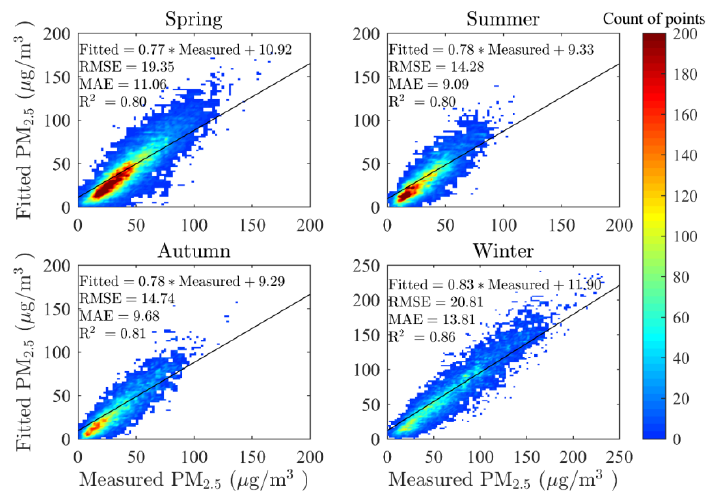
Figure 3. Scatter plot of cross-validation results in the real-time geographically weighted regression (GWR) model in four seasons. MAE: mean absolute error ( µ g/m 3 ); RMSE: root mean square error ( µ g/m 3 ). The solid line indicates the linear regression